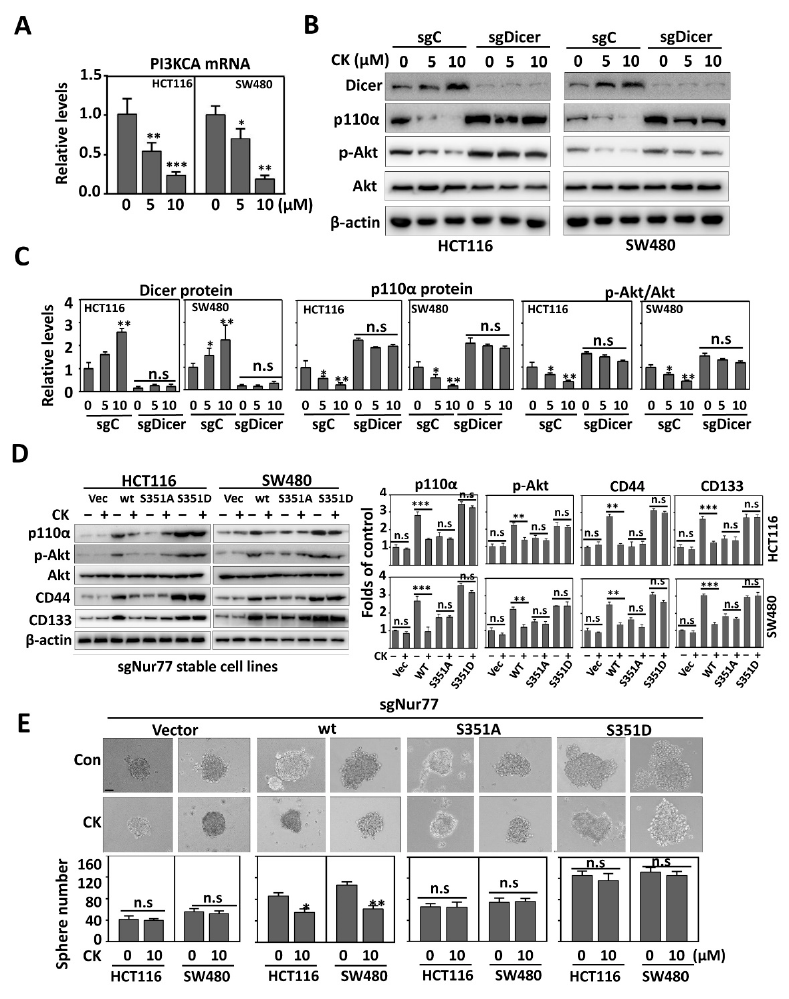
Figure 6. The depletion of CSC markers by CK is associated with Nur77-mediated Akt inactivation. ( A ) CRC cells were treated with vehicle, 5 μ M, or 10 μ M CK for 24 h under hypoxic conditions. The mRNA level of PIK3CA was examined by qPCR. ( B ) Dicer/WT and Dicer/KO cells were treated with vehicle, 5 μ M, or 10 μ M CK for 24 h. ( C ) The quantification of protein levels based on bot grey intensities in ( B ). ( D ) Nur77/KO cells were transfected with indicated Nur77 mutants and treated with or without 10 μ M CK for 24 h. For ( B , D ), the protein expression levels were examined by Western blotting. ( E ) Nur77/KO cells were transfected with indicated plasmids and cultured as tumor spheres in the presence or absence of 10 μ M CK. Spheres (> 50 μ m) were photographed and counted (scale bar, 50 μ m). * p < 0.05; ** p < 0.01; *** p < 0.001 vs. respective control. n.s. = non-significant. sgC = sgControl. Molecular weights for proteins are indicated in the full, uncropped, annotated Western blot images (Figure S8).